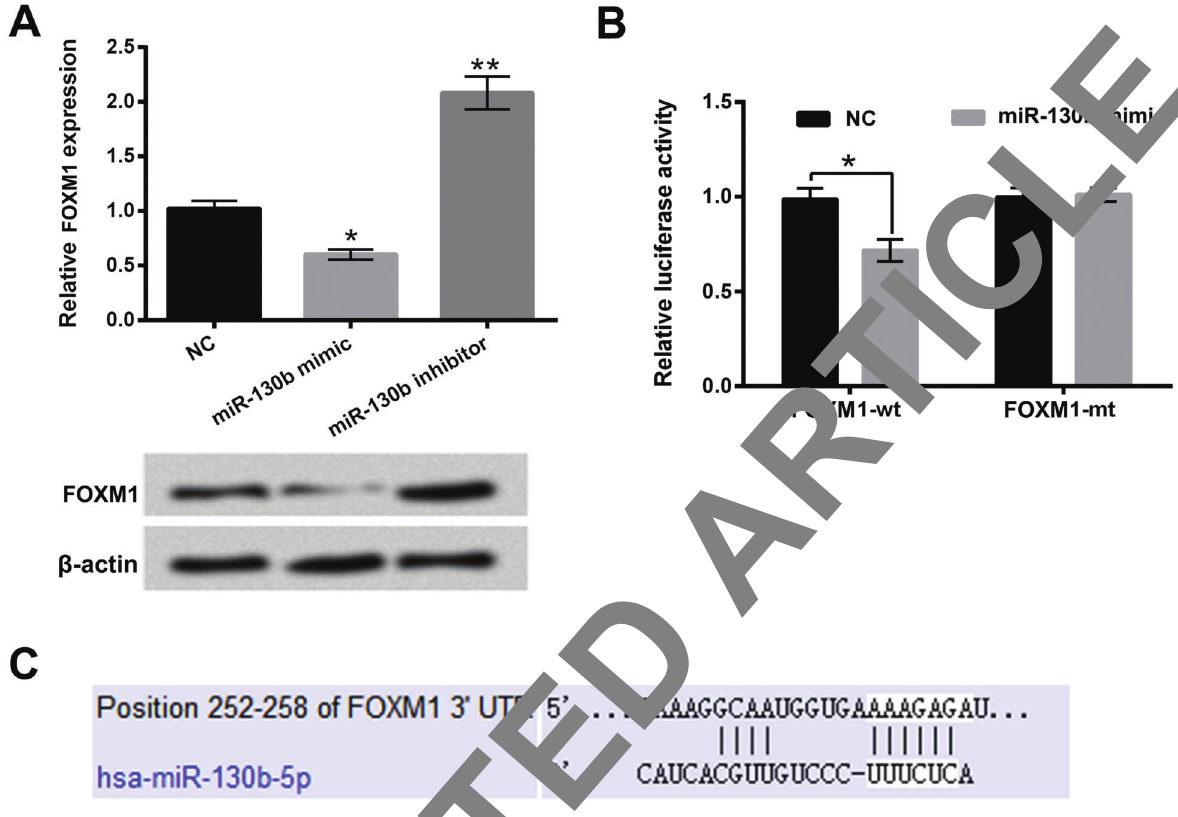
Figure 5. FOXM1 was a target gene of miR-130b in GH3 cells. A , The mRNA and protein expression levels of FOXM1 in GH3 cells after miR-130b mimic or miR-130b inhibitor transfection were determined using qRT-PCR and western blotting. B , Relative luciferase activities were detected after co-transfection with miR-130b mimic and FOXM1-wt (FOXM1-mt). C , Bioinformatics analysis was used to predict the potential binding sequence between miR-130b and 3 0 UTR of FOXM1. miR-130b: microRNA-130b; FOXM1: forkhead box protein M1; NC: negative control; wt: wild type; mt: mutated type. Data are reported as means ± SD.*P o 0.05; **P o 0.01